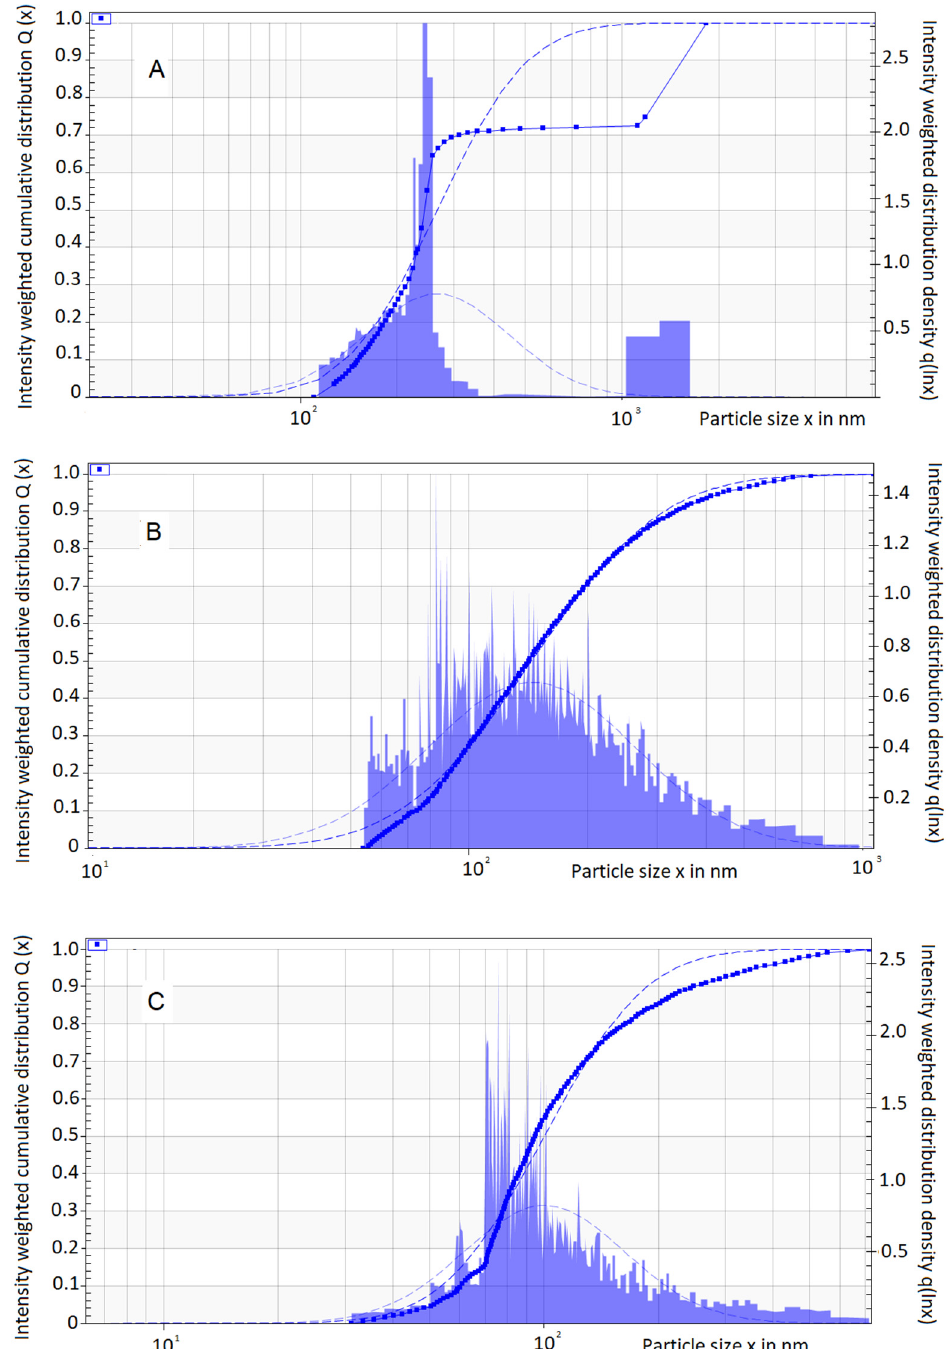
Figure 5. Graphical representation of droplet (particle) size distribution as a function of velocity, for batches prepared at different times: ( A ) 4 w.o., ( B ) 3 w.o., and ( C ) 1 w.o. Intensity-weighted distribution density (right vertical axis), intensity-weighted cumulative distribution (left vertical axis), and particle size (horizontal axis) are